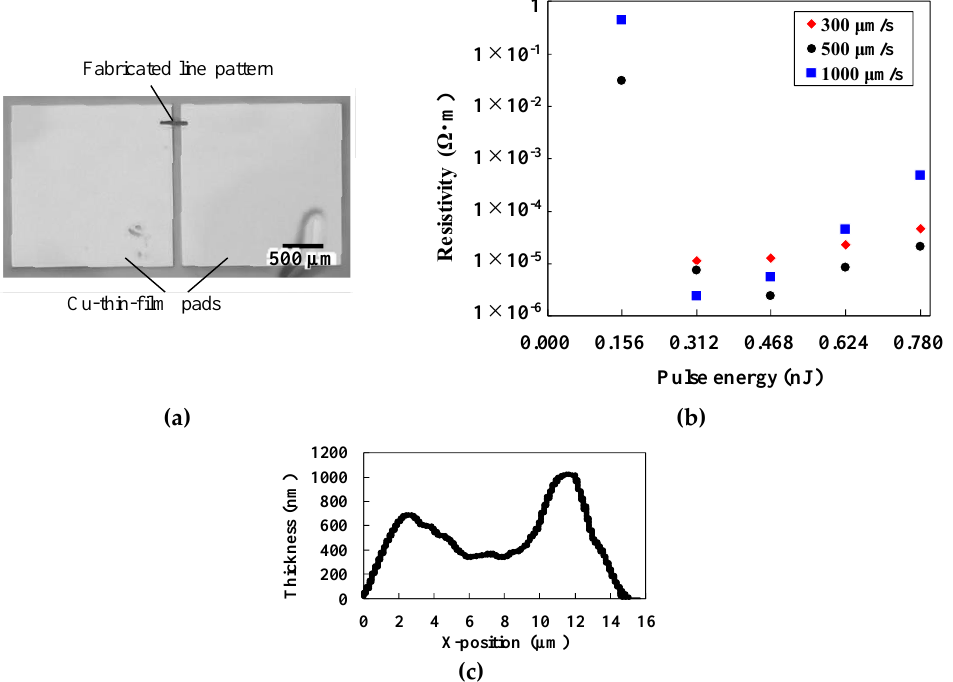
Figure 4. ( a ) Optical microscope image of a typical line pattern connecting two Cu thin film pads. ( b ) Resistivity of micropatterns fabricated under various laser irradiation conditions. ( c ) Cross-sectional profile of a line pattern produced at scanning speed of 500 µm/s and pulse energy of 0.468 nJ.